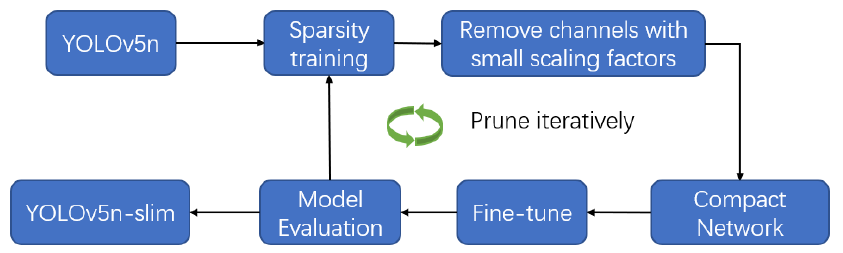
Figure 7. Model-pruning algorithm process.